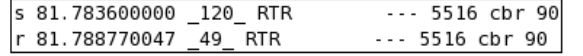
Figure 9. Packet transfer without encryption.